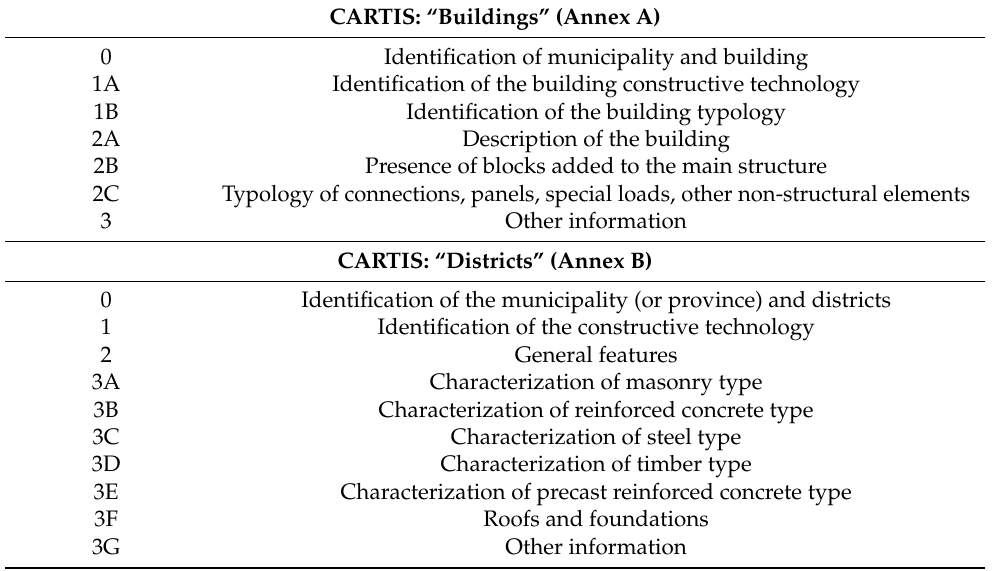
Table 1. Contents of the CARTIS